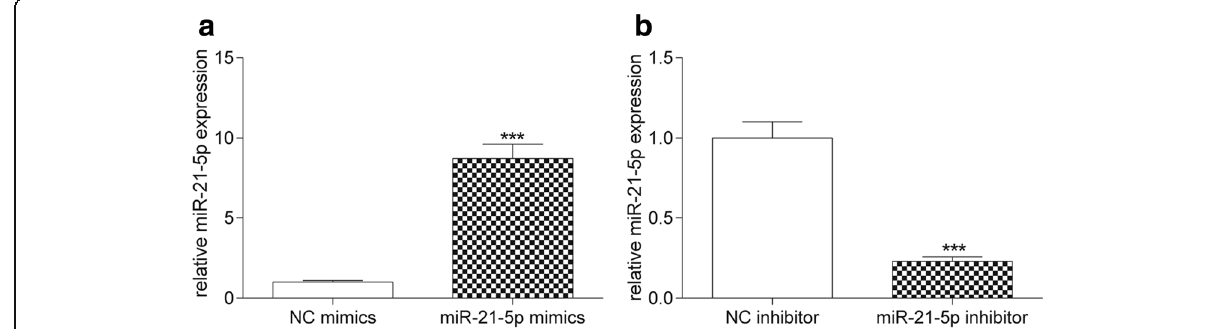
Fig. 2 The transfection of miR-21-5p mimics and miR-21-5p inhibitor. a The result of qRT-PCR showed that miR-21-5p expression in miR-21-5p mimics was much higher than that in NC mimics. *** P < 0.001, compared with NC mimics. b MiR-21-5p expression in miR-21-5p inhibitor was